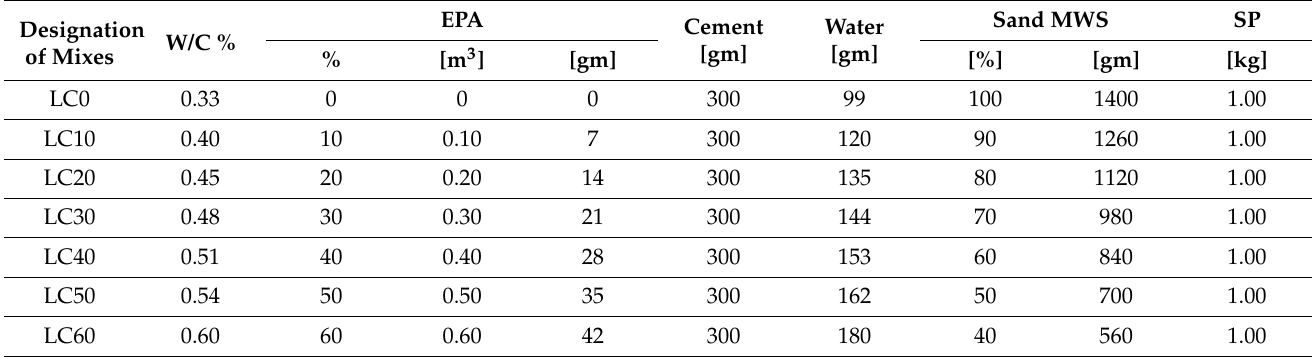
Figure 5. Plate and cubic concrete specimens. Table 3. Mix composition of proposed lightweight concrete blends (As